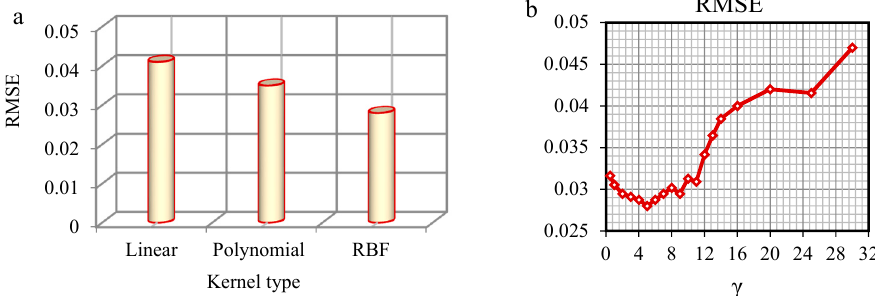
Figure 3. Root Mean Square Error (RMSE) statistics parameter via ( a ) KELM kernels function types and ( b ) γ values to find KELM optimums of testing set for the model M (V).